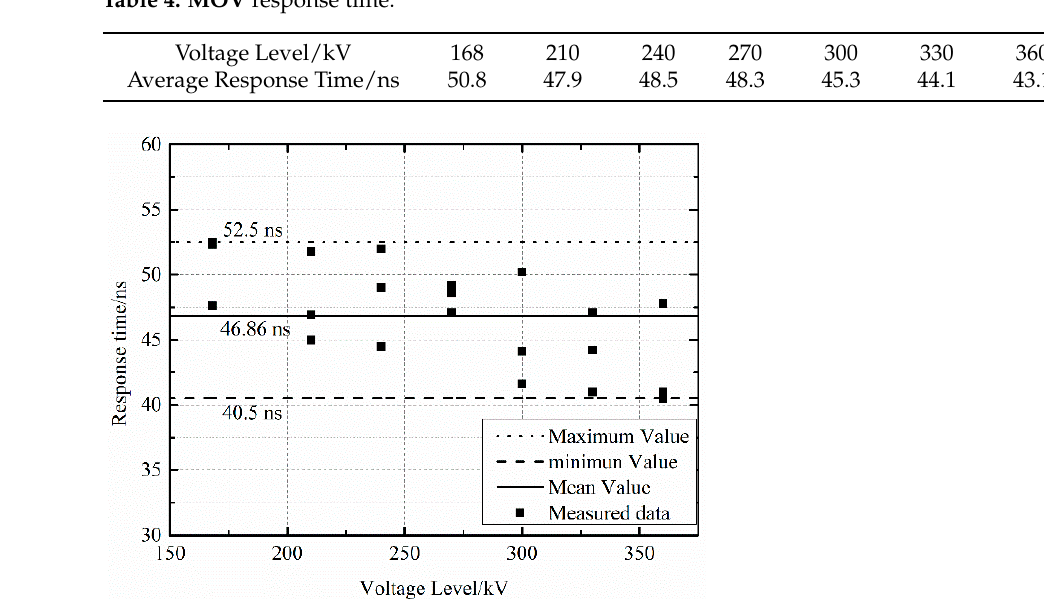
Figure 8. Response time at different voltage levels.